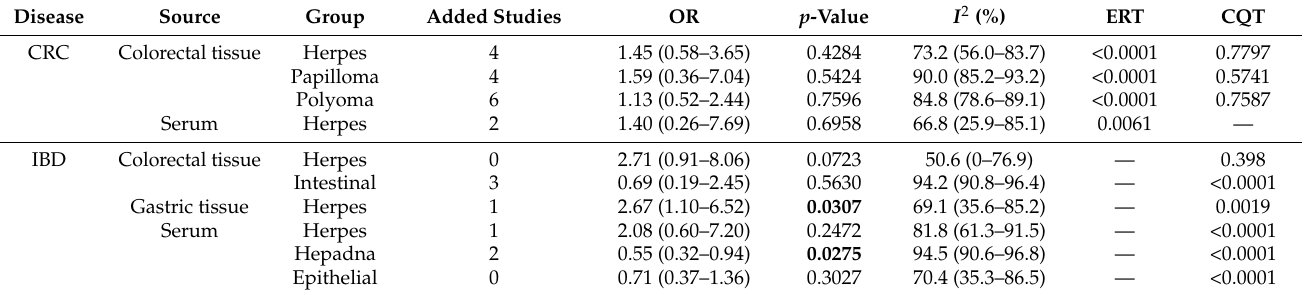
Table 2. Trim-and-fill model for the risk of CRC, GC, and IBD, predicted by the studies selected for the present meta-analysis. The model added a specified number of studies to adjust for the publication bias. The studies are stratified by specimen type (Source) and virus type (Group). The ORs are reported with their 95% confidence interval and p -value. I 2 = Higgins index; ERT = Egger’s regression test; CQT = Cochran’s Q